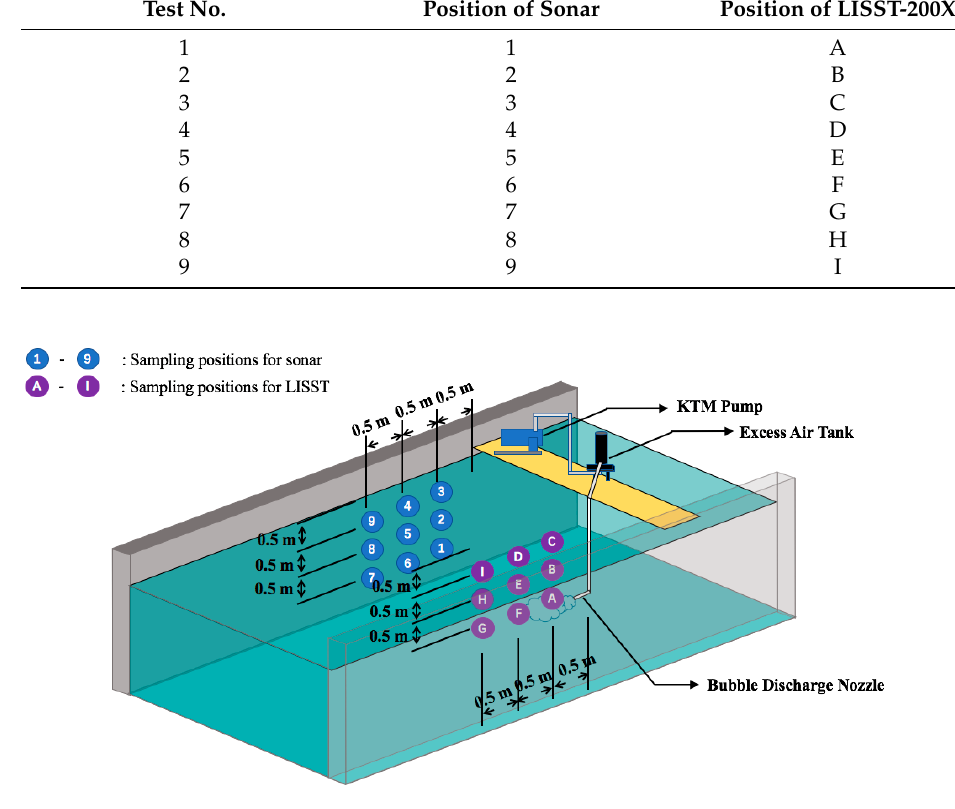
Figure 7. Sampling positions for the sonar and LISST-200X in the tow